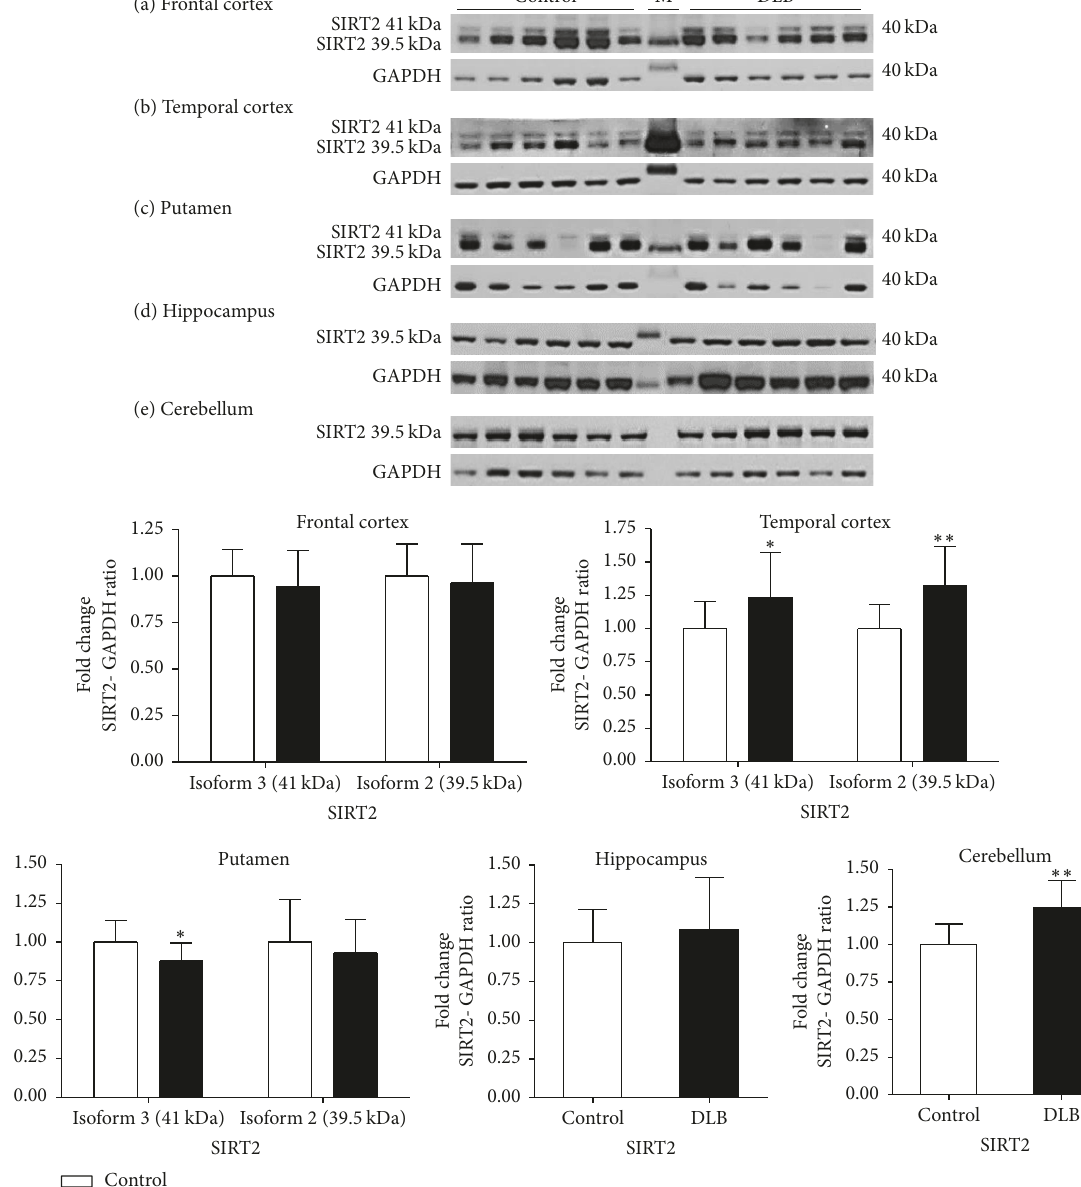
Figure 8: Expression of SIRT2 in different brain regions in dementia with Lewy Bodies. The levels of SIRT2 were determined in different regions of DLB patients and were compared to a control-cohort. SIRT2 band intensity was normalised with GAPDH. Data are presented as fold change ( ± SD) with respect to control from three independent replicates. ∗∗ 𝑝 < 0.01 , and ∗ 𝑝 < 0.05 when compared to control; statistical analysis was done through 𝑡 -test performed on GraphPad prism. Images are representative blots of SIRT2 and GAPDH. M indicates molecular weight marker